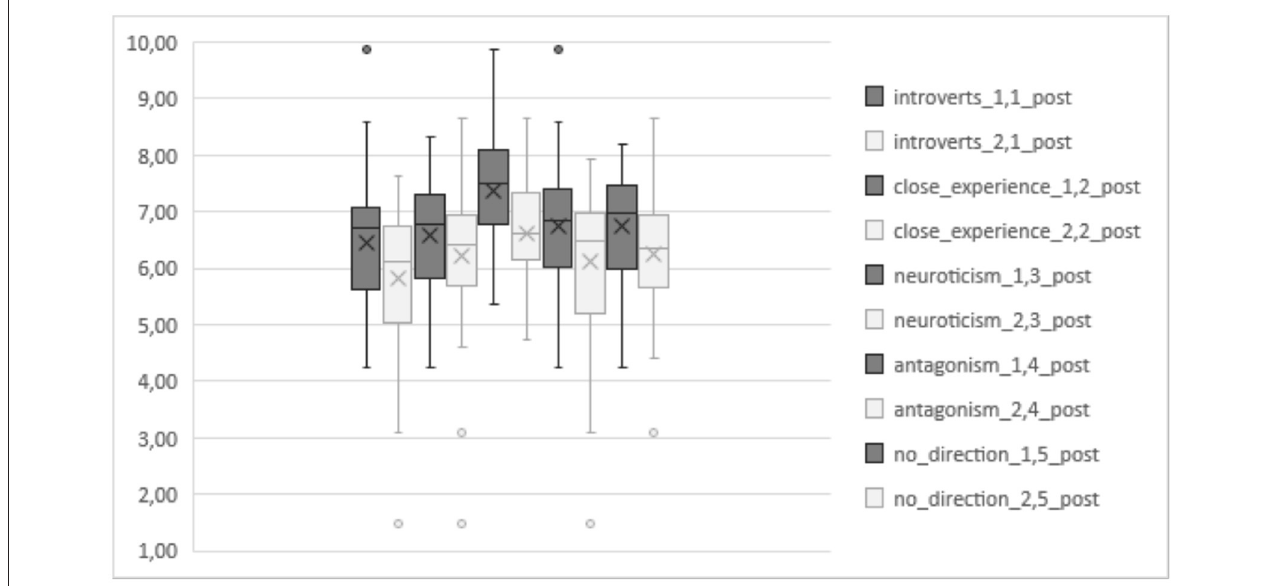
FIGURE 2 | Emotional competence (EC) posttest means in subgroups 1 and 2 (experimental and control subgroups).